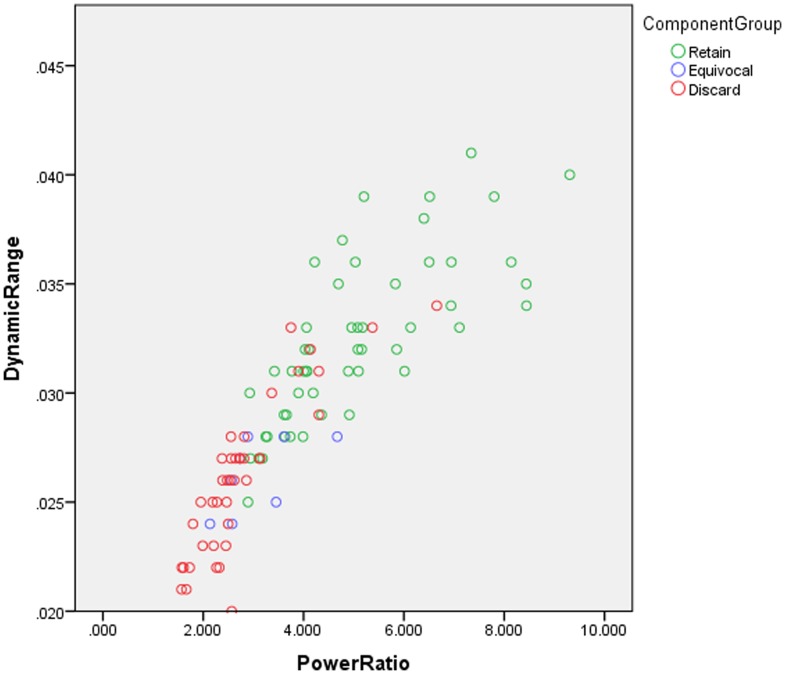
Data processing stream for fMRI pre-processing, ICA, and graph theory.